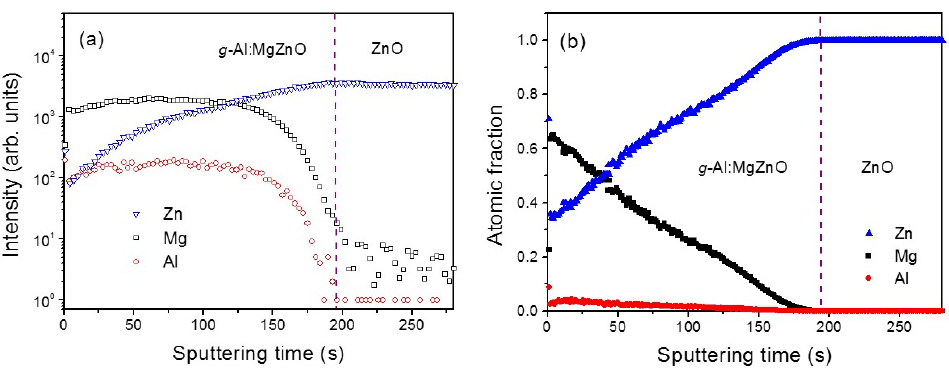
Figure 2. ( a ) SIMS depth profiles of the elements and ( b ) the atomic fractions estimated from the SIMS results for the g -Al:MgZnO/ZnO heterostructure film.